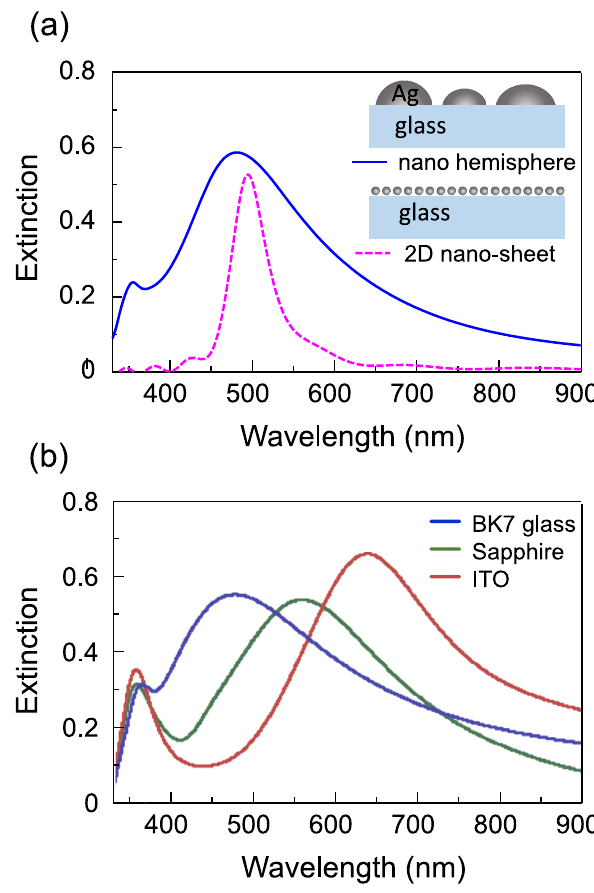
Figure 2: (a) Extinction spectra acquired from the nanohemisphere on the BK7 glass substrate and the 2D nanosheet structures of the Ag nanoparticles on quartz substrate. (b) Extinction spectra of Ag nanohemisphere on BK7 glass, saphere, and indium tin oxide (ITO)